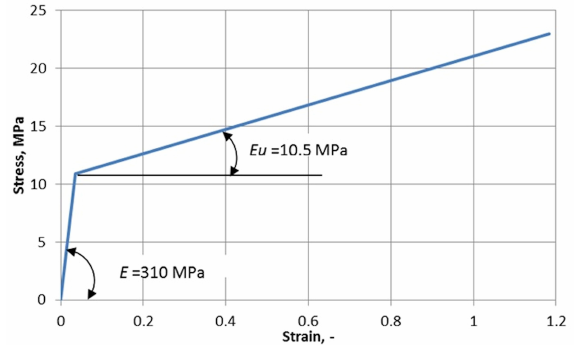
In the Fig. 3 the axi-symmetrical model was presented. The whole assembly was discretized with planar element type PLANE 183 whit higher order shape function.